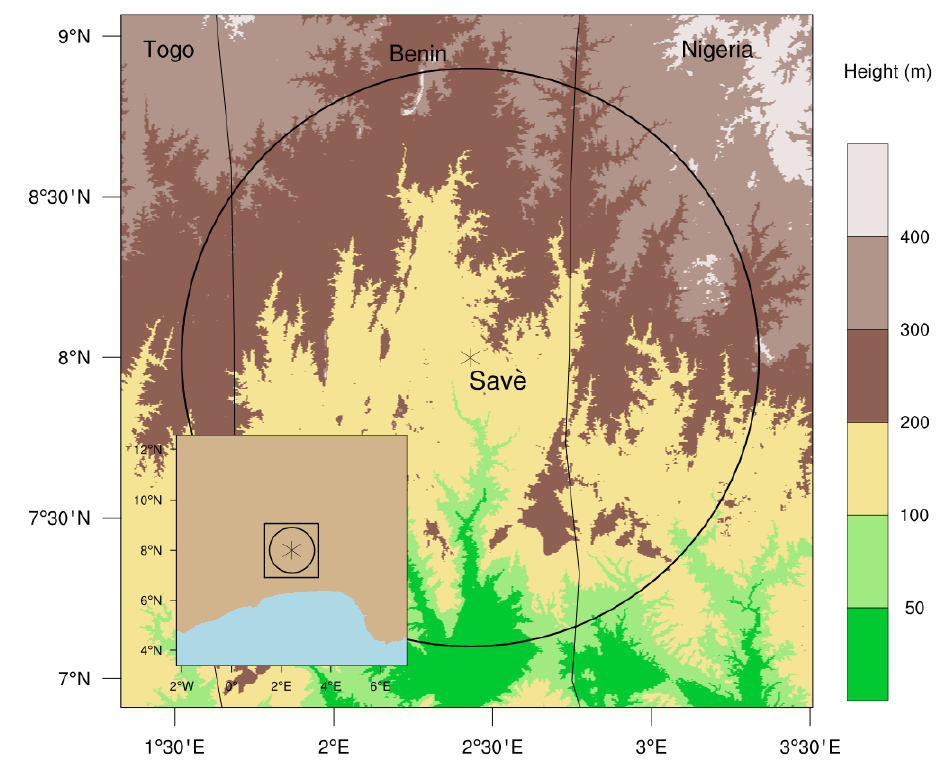
Figure 2. Meso-NH domain for the 200-m simulation, colour-shaded is the orography. The domain for the 1-km simulation is shown in the insert. The circles indicate the 100-km range of the X-band radar located at